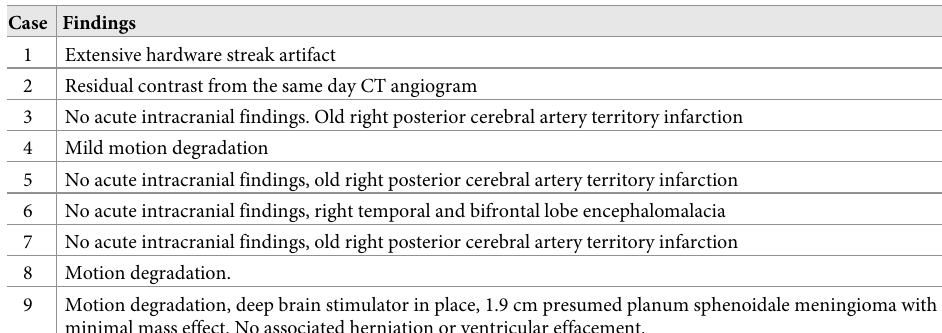
Table 3. False positive IC+